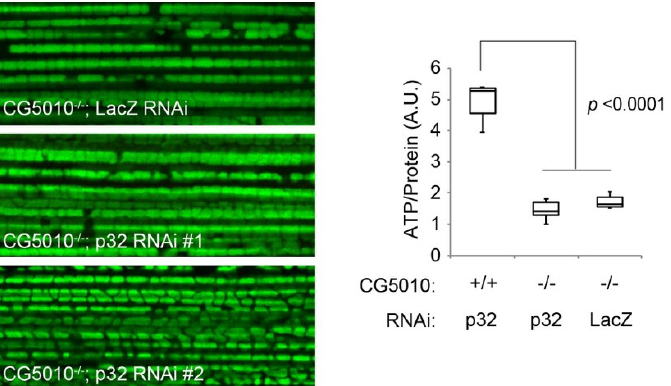
Figure 5. No evidence of genetic interaction between Drosophila CHCHD2/D10 orthologue, CG5010, and p32 . ( Left ) Mitochondria in the indirect flight muscles were visualized by mitoGFP (green). Although p32 -deficient flies are lethal, muscle-specific reduction of p32 does not affect muscular mitochondria. Reduction of p32 in CG5010 null flies does not change the mitochondrial morphology. Two independent p32 RNAi lines obtained from the NIG-fly were employed. LacZ RNAi served as mock control. ( Right ) Loss of CG5010 resulted in reduced ATP production ( p < 0.0001, CG5010 +/+ with p32 RNAi vs . G5010 -/- with p32 RNAi by Tukey–Kramer’s test), which was not affected by p32 inactivation ( p = 0.5546, G5010 -/- with p32 RNAi vs . G5010 -/- with LacZ RNAi). n = 5–6 in each group. A.U., arbitrary units. Transgenes were driven by muscle-specific MHC-GAL4